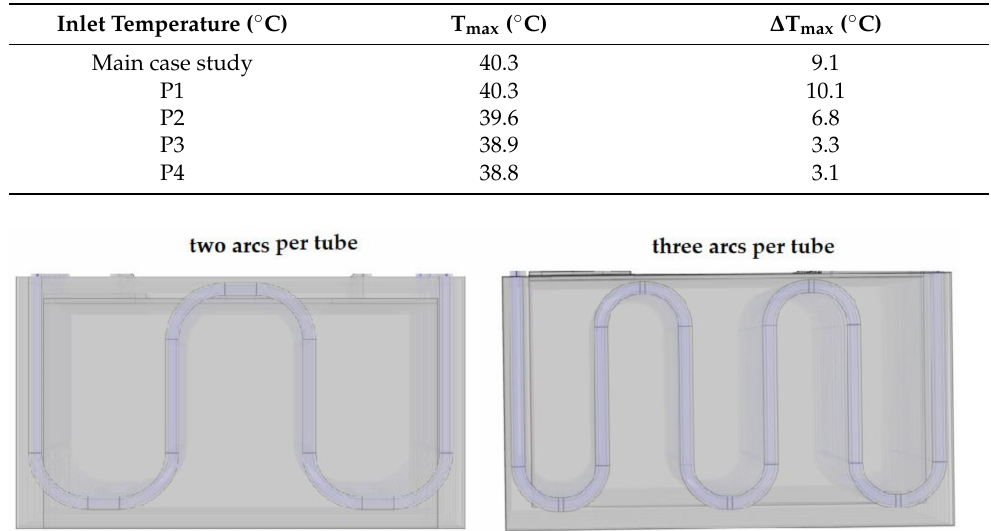
Figure 18. Various arc numbers per tube in the path of the cold